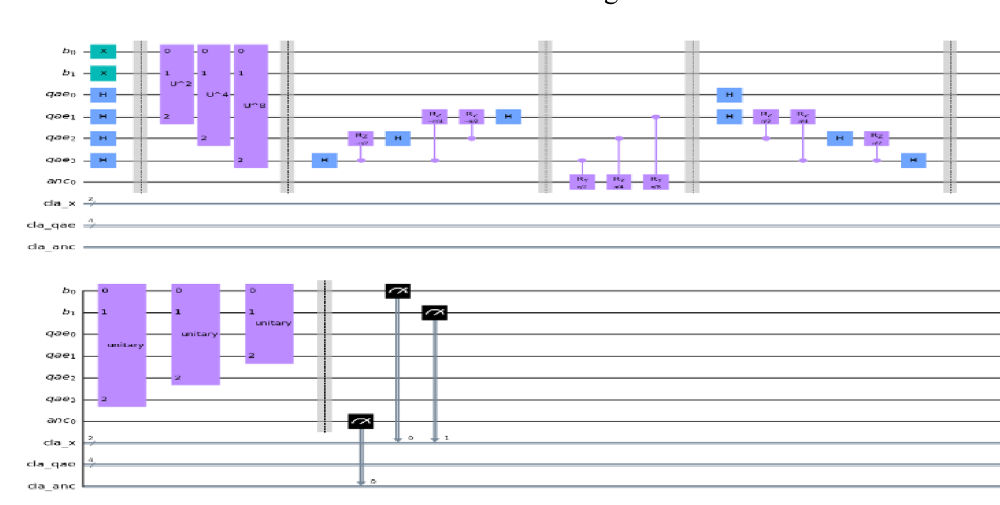
Figure 6. Comparison of the generic circuit of HHL algorithm and improved circuit implementation of the HHL